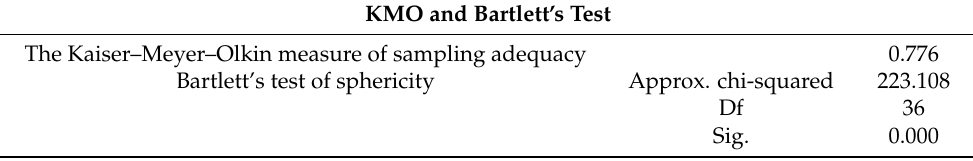
Table 3. Results of validity